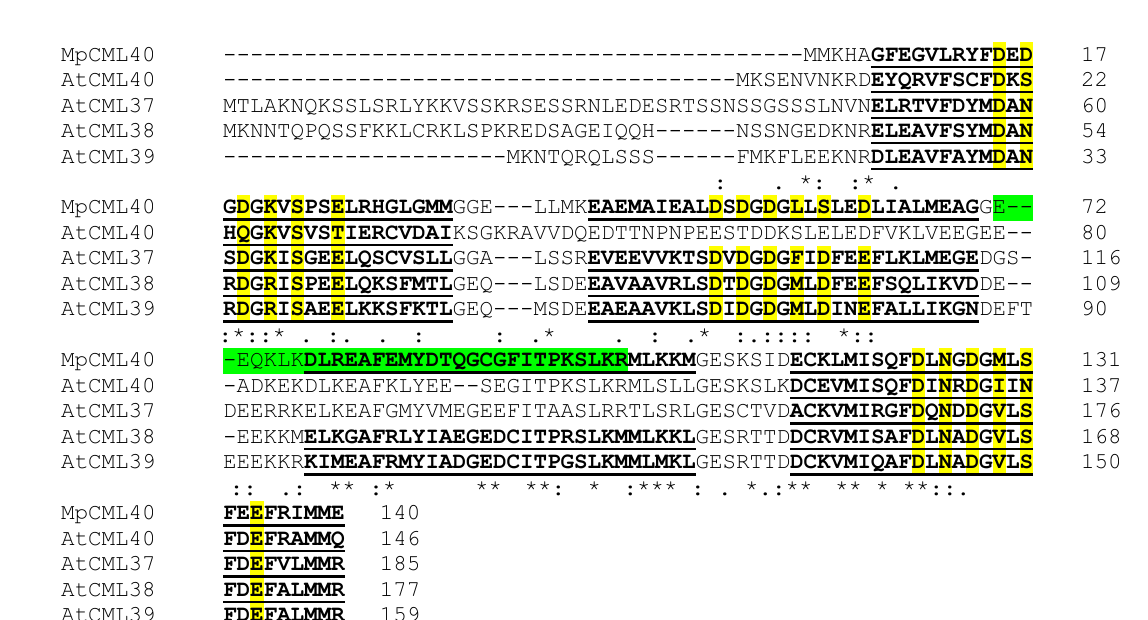
Figure 2. Amino acid sequence alignment of MpCML40, AtCML37, AtCML38, AtCML39, and AtCML40. The EF-hand motifs were underlined, and the highly conserved amino acids in EF-hand motifs were highlight by yellow color. A predicted bipartite Nuclear Localization Signal (NLS) was highlighted by green color.